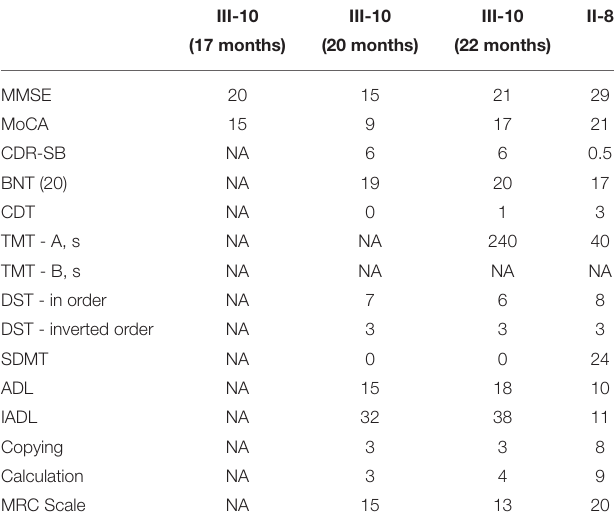
TABLE 3 | Summary of cognitive abilities test in examined family